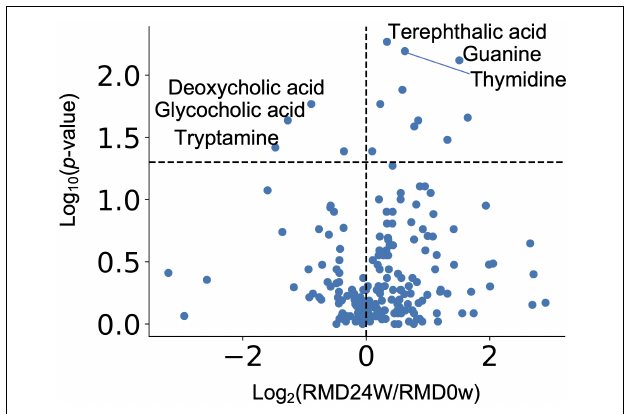
FIGURE 3 | Effect of RMD intake on intestinal metabolite concentrations. Volcano plot representing the influence of the test food on each intestinal metabolite. X axis indicates the magnitude of influence (log fold change of mean value of corresponding metabolite abundance after 24 weeks of intervention relative to the control time point). Y axis indicates the significance of influence (logarithmic value of p -value). A dotted line has been drawn at − log 10 p -value ( p =